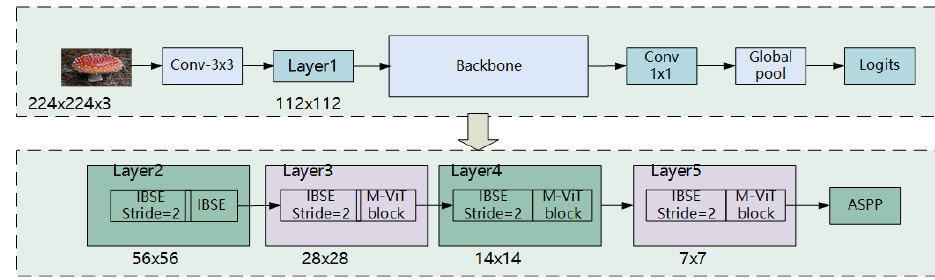
Figure 4. The M-ViT pipeline.